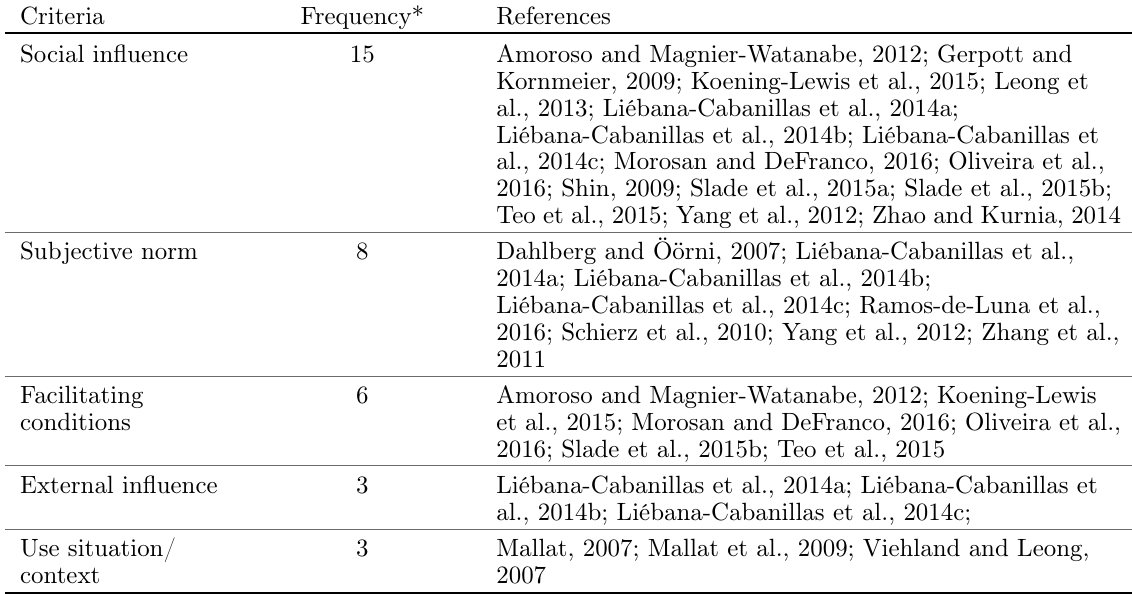
Table C.5. Constructs related to external